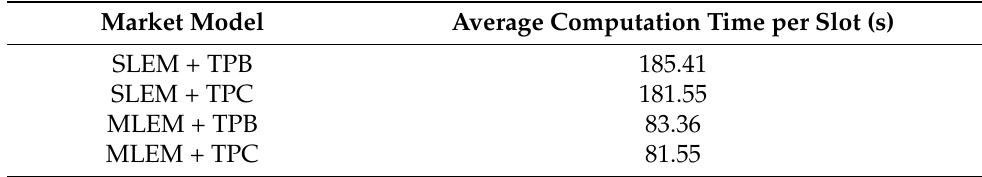
Table 4. Average computational time per time slot for in different local market